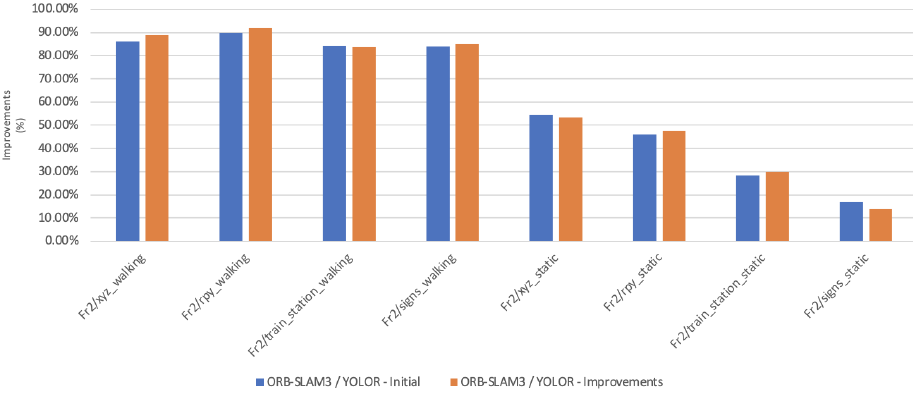
Figure 15. Accuracy improvements of ORB-SLAM3/YOLOR.